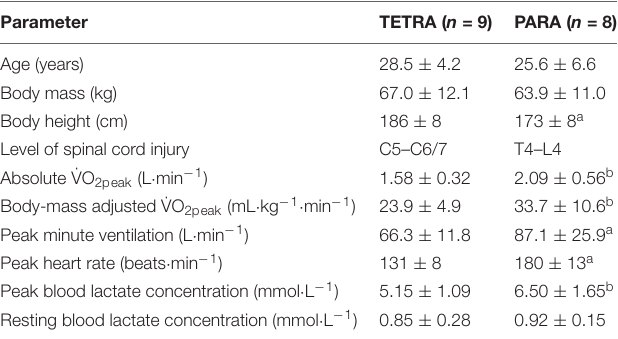
TABLE 1 | Age, anthropometric characteristics as well as peak cardio-respiratory parameters of the 17 wheelchair athletes participating in this study.